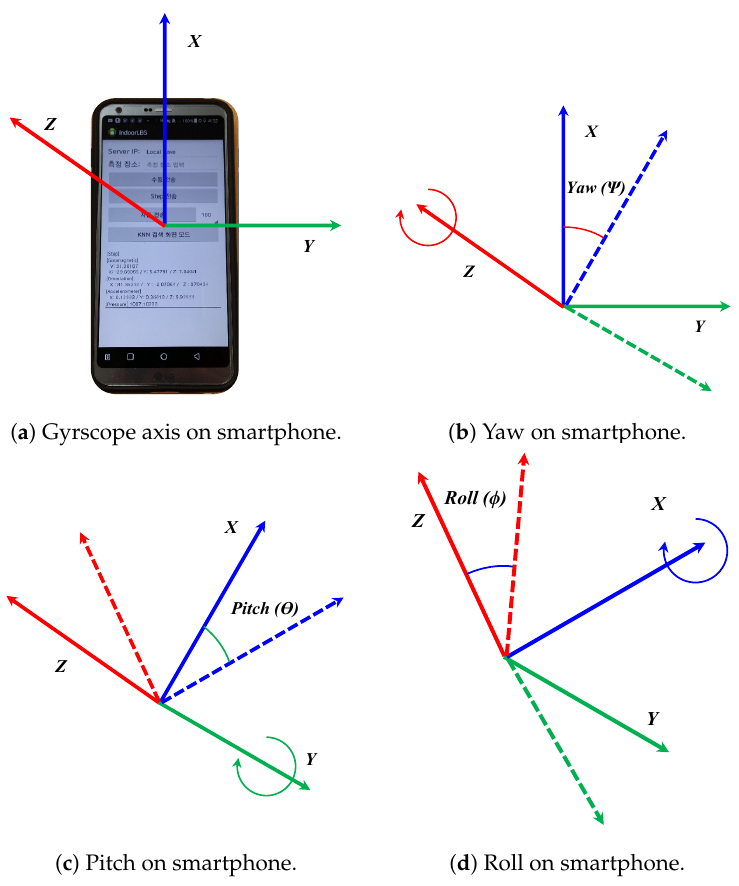
Figure 11. The yaw, pitch, and roll on a